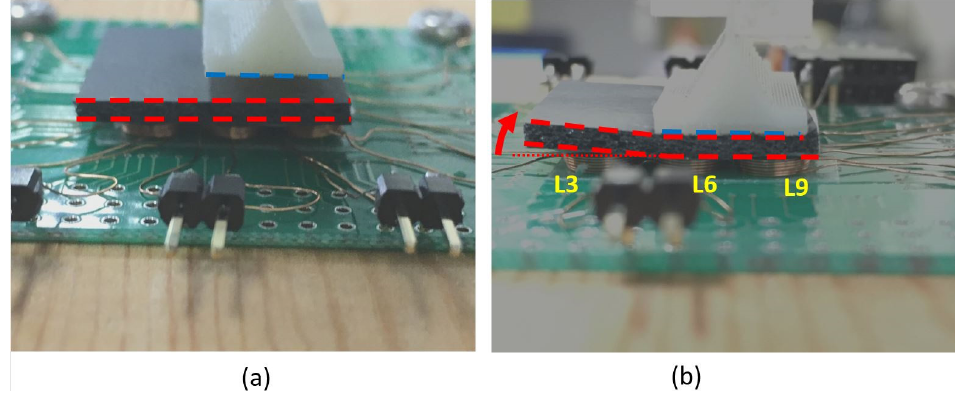
Figure 10. Application of the deformation for the case presented in Figure 7; ( a ) before the application of the deformation and ( b ) after the application of the